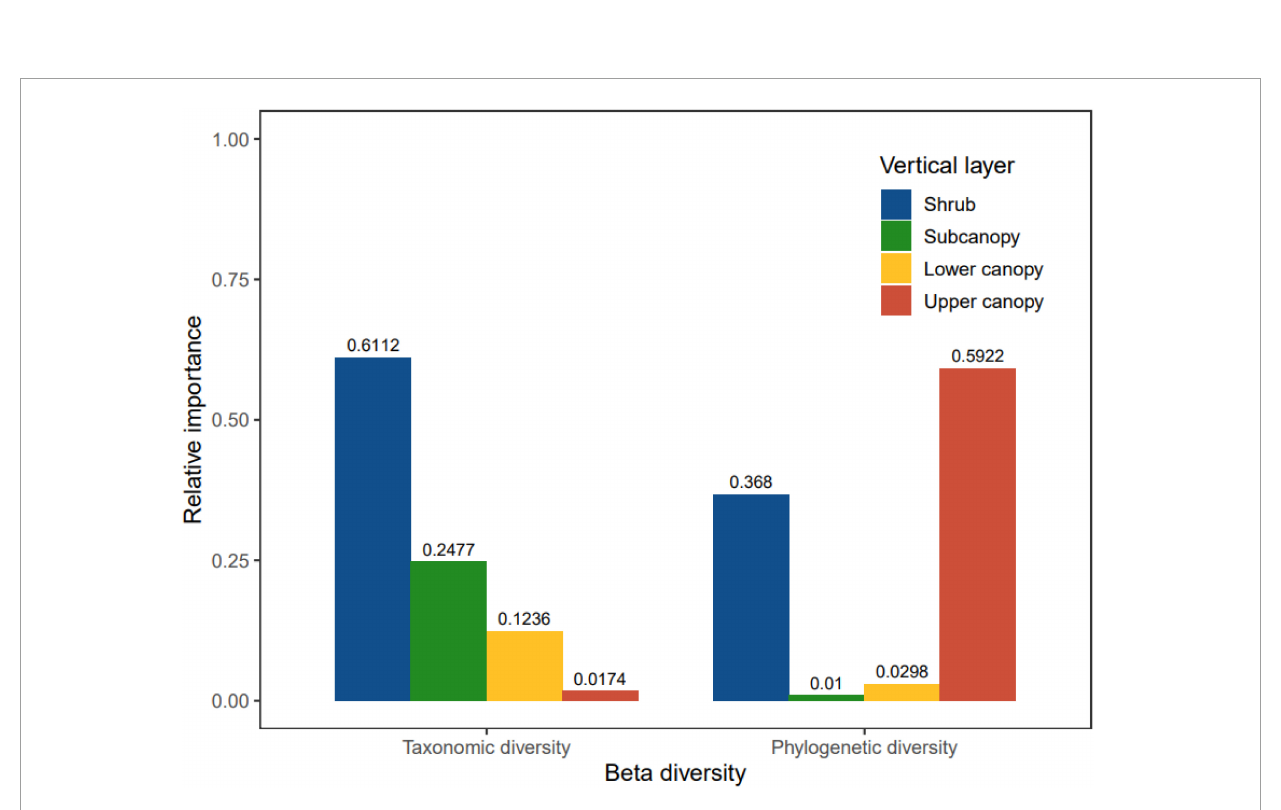
FIGURE5 The relative contribution of different vertical stratification to temporal taxonomic and phylogenetic beta diversity in the Dongbaishan forest.